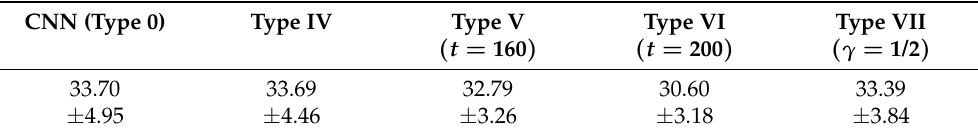
Table 3. Average error rates of the CNN without (type 0) and with image correction methods of type IV, V, VI, and